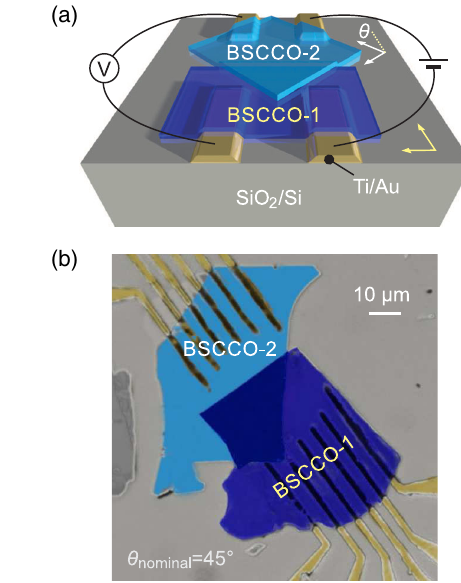
FIG. 1. High- T c Josephson junction. (a) Top: schematic drawing of the Josephson junction made of two overlapping BSCCO flakes on a SiO 2 = Si substrate. (b) False-color image of a 45° twist junction with prepatterned Ti = Au electrodes taken by an optical microscope. Each flake has a thickness of about 10 unit cells ( ∼ 30